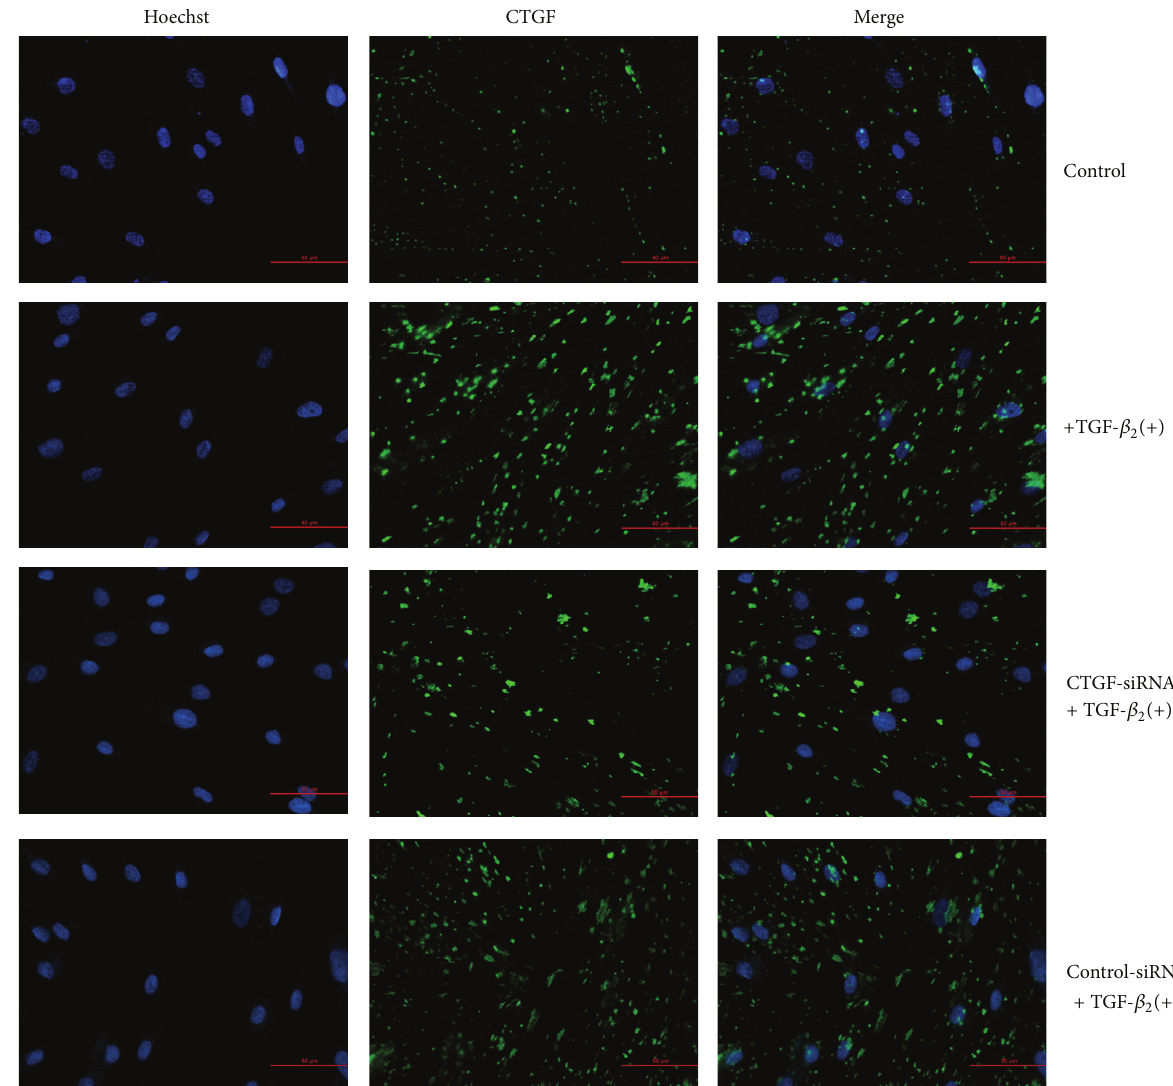
Figure 4: Suppression of CTGF protein expression in HTFs by siRNA. HTFs were stimulated with TGF- 𝛽 2 for 48h after cells were transfected with CTGF-siRNA or control siRNA. Immunofluorescence analysis of HTFs was performed to visualize the CTGF protein in cell matrix (in green) after various treatments. Nuclei stained with Hoechst were seen in